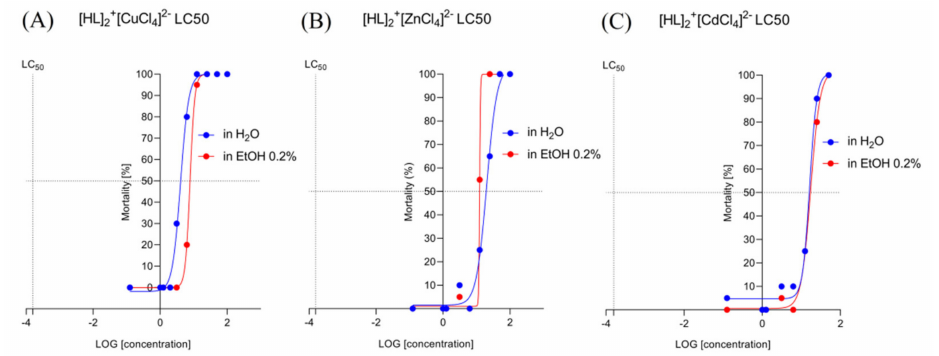
Figure 7. The lethal concentrations (LC50) (log[concentration]) detected for [HL] 2+ [CuCl 4 ] 2 − ( A ), [HL] 2+ [ZnCl 4 ] 2 − ( B ), and [HL] 2+ [CdCl 4 ] 2 − ( C ) in a solvent-dependent manner of changes (water, H 2 O/ethanol, EtOH